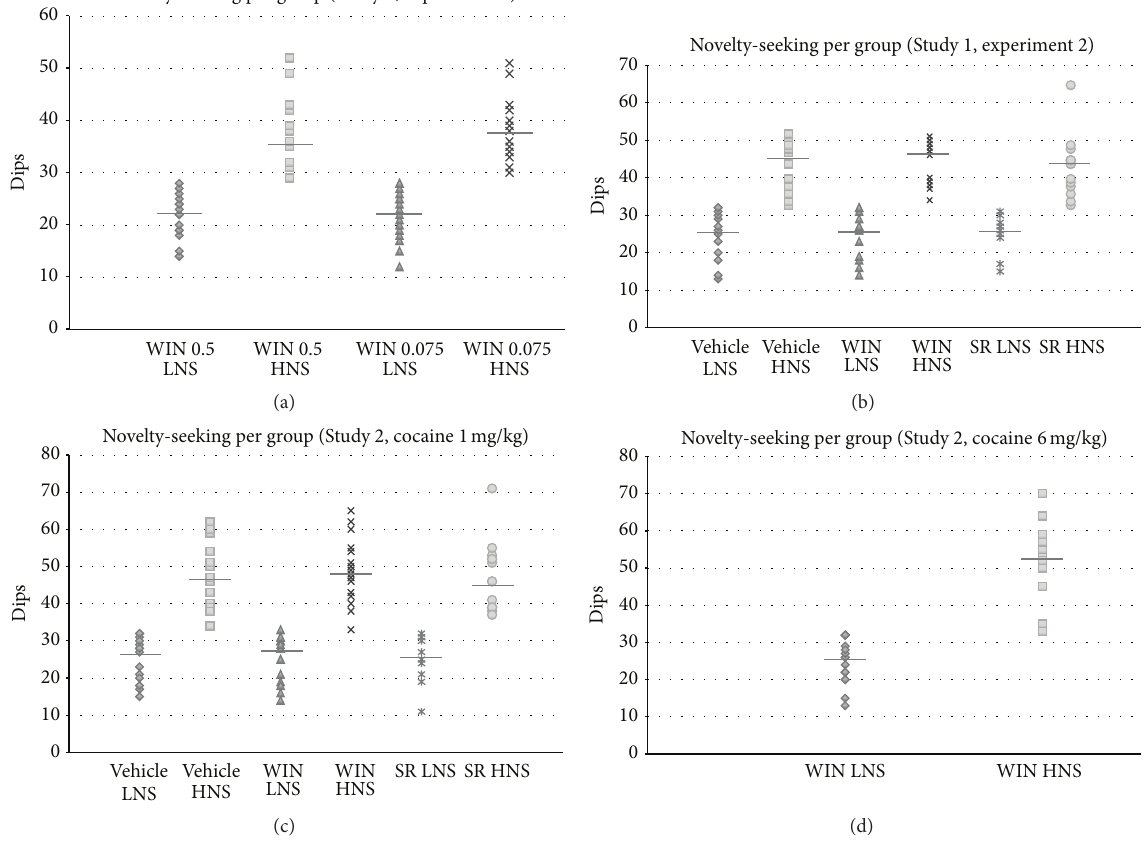
Figure 2: Novelty scores for each mouse, identified by group, in Study 1 ((a) experiment 1 and (b) experiment 2) and Study 2 ((c) mice conditioned with 1mg/kg of cocaine and (d) mice conditioned with 6mg/kg of